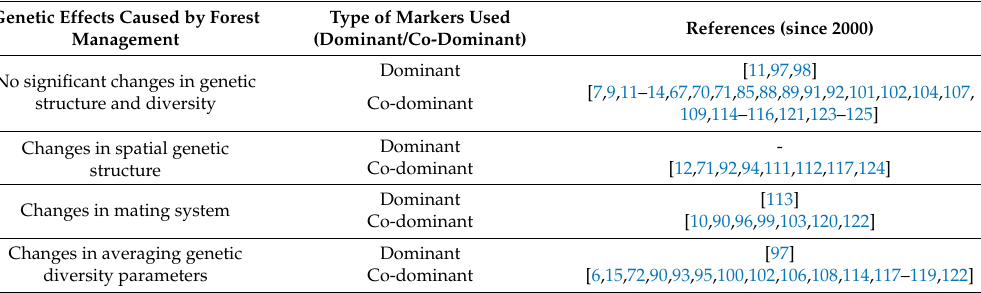
Table 3. Summary of studies on genetic effects of forest management practices. Genetic Effects Caused by Forest